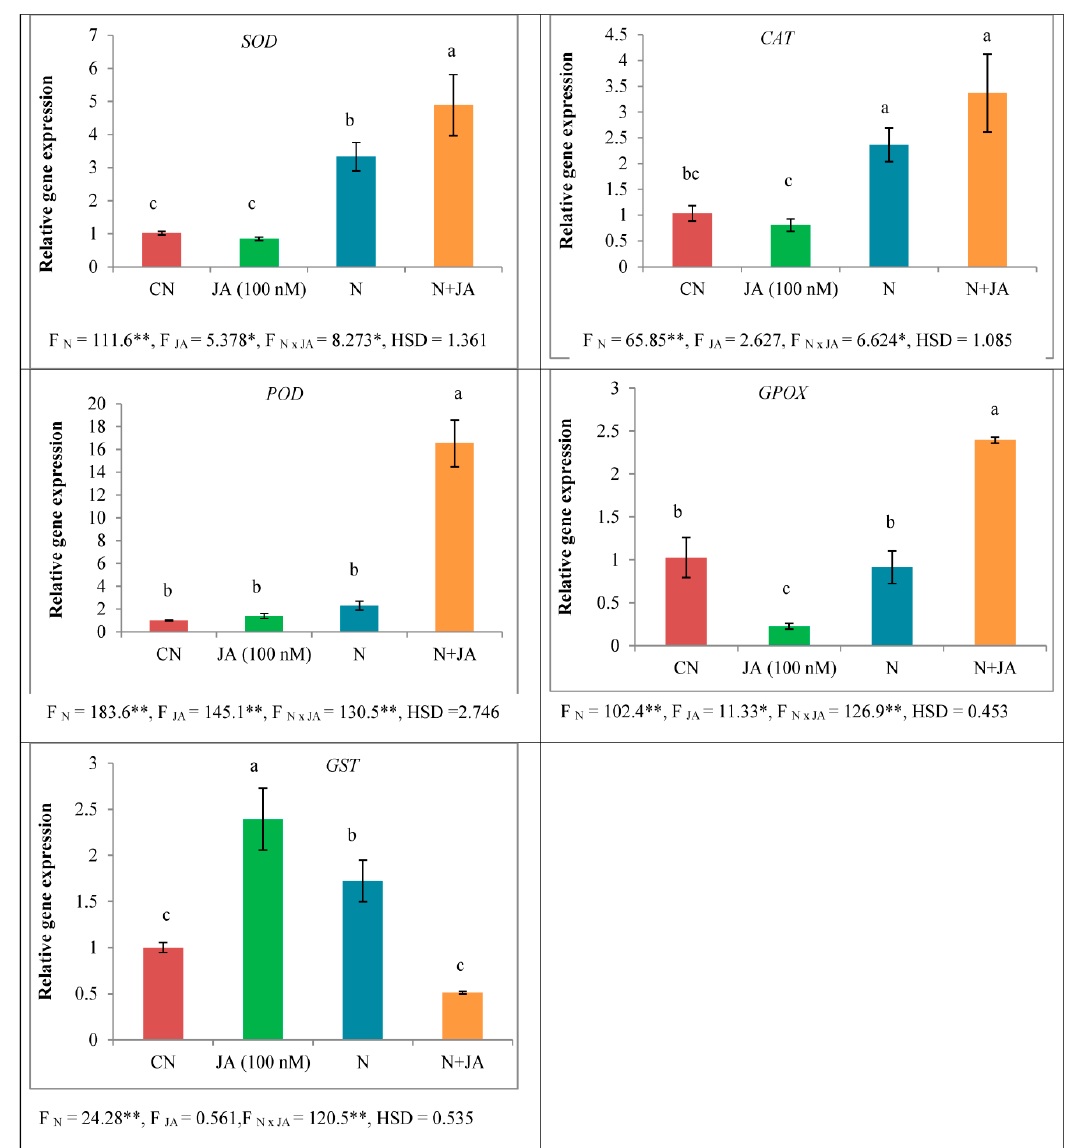
Figure 4. Effect of seed soaking treatment of JA (100 nM) on the expression of antioxidative enzymes ( SOD , POD , CAT , GPOX, and GST ) in tomato seedlings after seven days of nematode inoculation. (Mean ± SD, two-way ANOVA, Tukey’s HSD). Means with similar letter are not significantly different from each other. * and ** designated significance at p ≤ 0.05 and p ≤ 0.01, respectively.